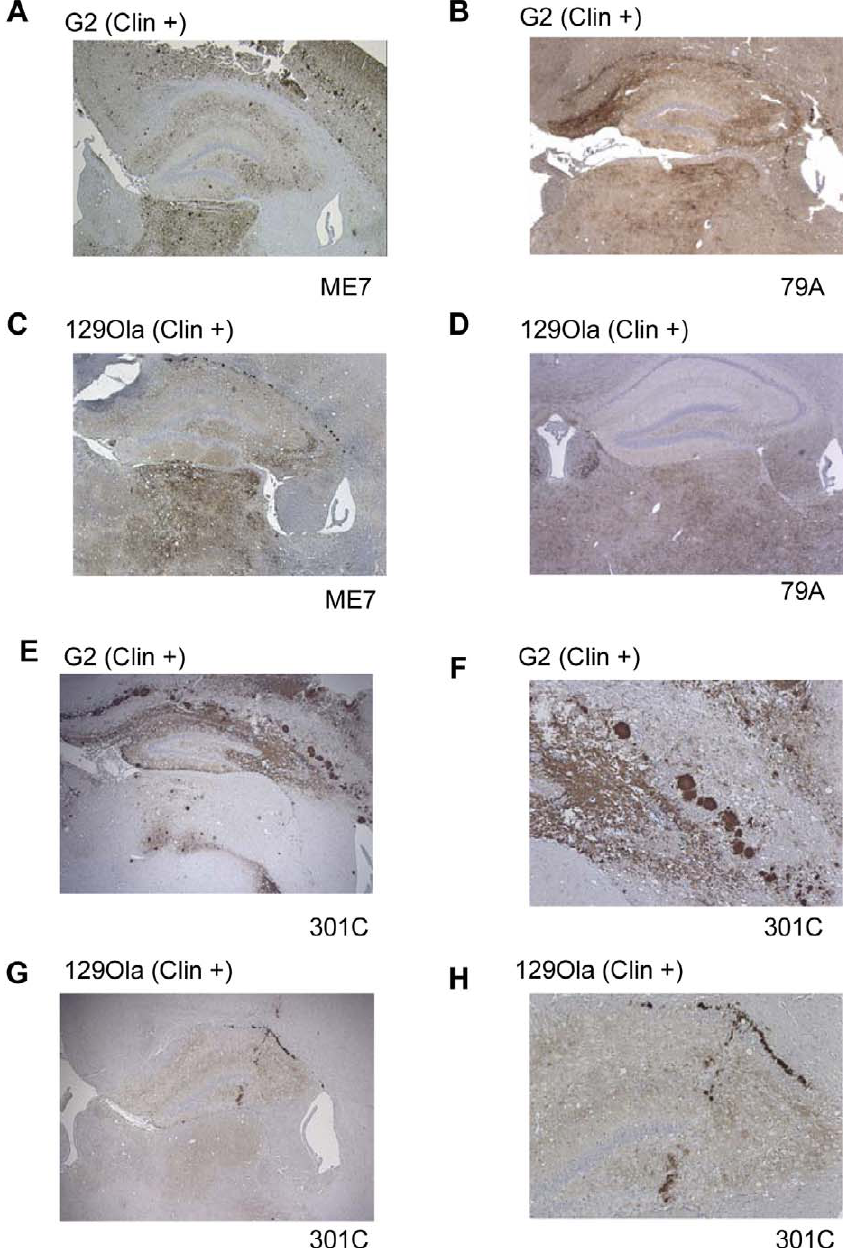
Figure 4. Immunohistochemical Analysis of Brain from G2 Mice Inoculated with TSE Strains ME7, 79A, and 301C Brain sections were immunostained for PrP using monoclonal antibody 6H4 and analysed by light microscopy using a Nikon Eclipse E 800 microscope. Brains from clinically positive G2 mice inoculated with (A) ME7 or (B) 79A showing wide spread PrP deposition. Brains from 129/Ola wild-type mice inoculated with (C) ME7 or (D) 79A also showing wide spread PrP deposition. The TSE strain 301C was used to inoculate (E and F) G2 mice, which showed wide spread plaque-like and fine punctuate PrP deposits in the cerebrum and cerebellum or (G and H) 129Ola mice, which also showed plaque-like PrP deposition. All 301C inoculated brains shown were from clinically positive mice. Magnifications: (A–E) and (G), 4 3 ; (F) and (H), 10 3